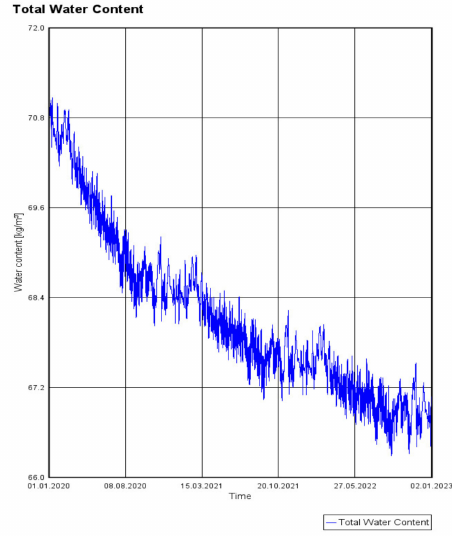
Figure 21. Changes in water content—partition insulated using light aerated